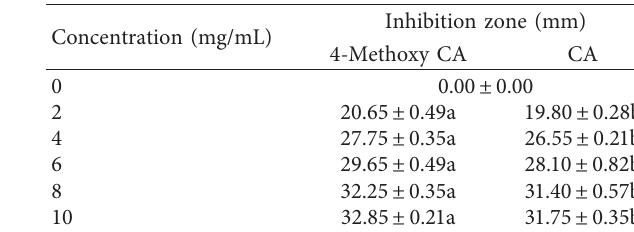
Table 2: Inhibition effects of 4-methoxy CA and CA against P. digitatum .